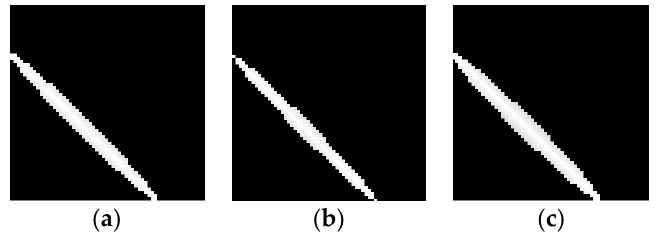
Figure 4. The coverage of different ellipse weight models ( a ) Model 1; ( b ) Model 2; ( c ) Model 3.